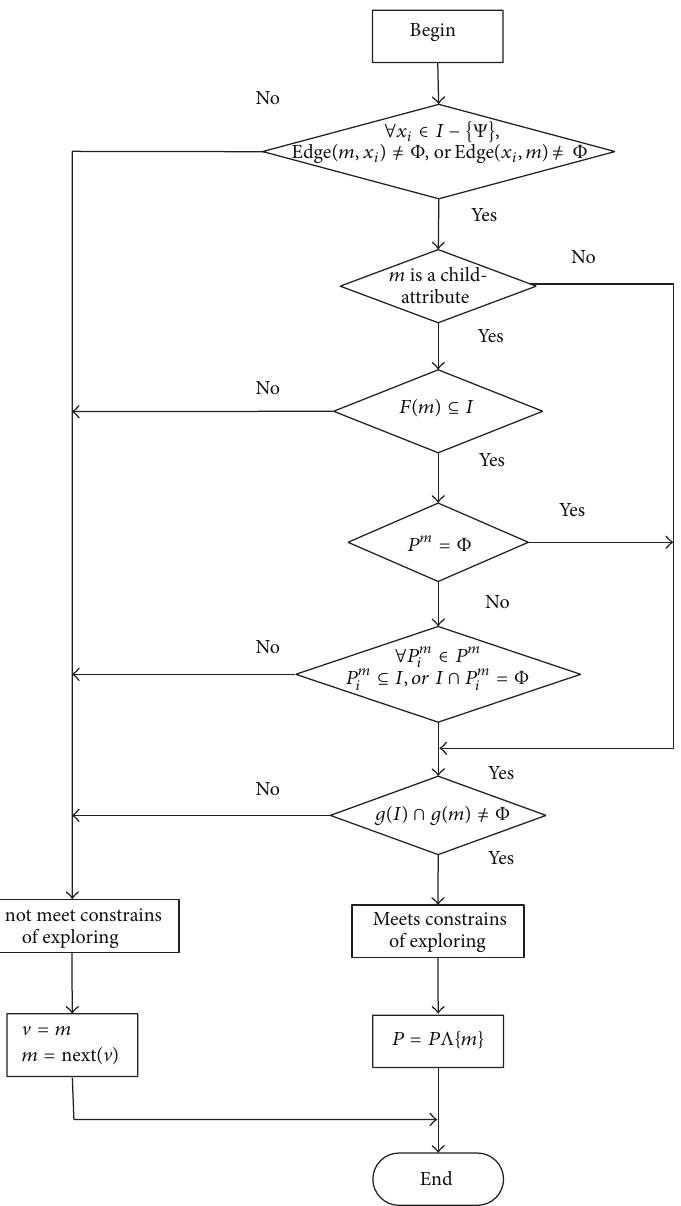
Figure 3: Flowchart of the process of exploring attribute 𝑚 and the constrains